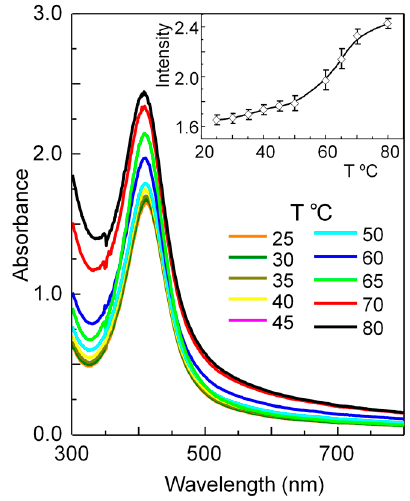
Figure 4. UV-Vis spectra of Ag–PU PEG 85 hydrogel nanocomposites when temperature increases from 25 to 80 °C. Inset: SPR band maximum intensity of Ag–PU PEG 85 as a function of the temperature. Table 3. Influence of AgNO 3 concentration on the SPR band (position and intensity) of PU hydrogel with 85%-mol of PEG (Ag–PU PEG 85, Table 2).